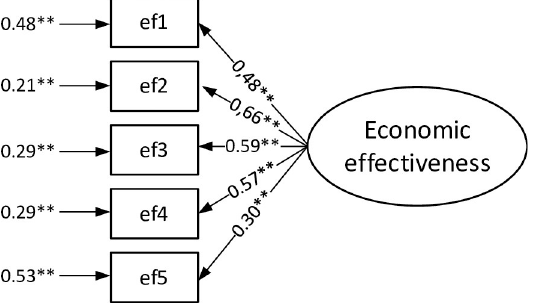
Fig 3. Confirmatory factor analysis for the measurement model of economic effectiveness (loadings and error variance). Source: Own study.